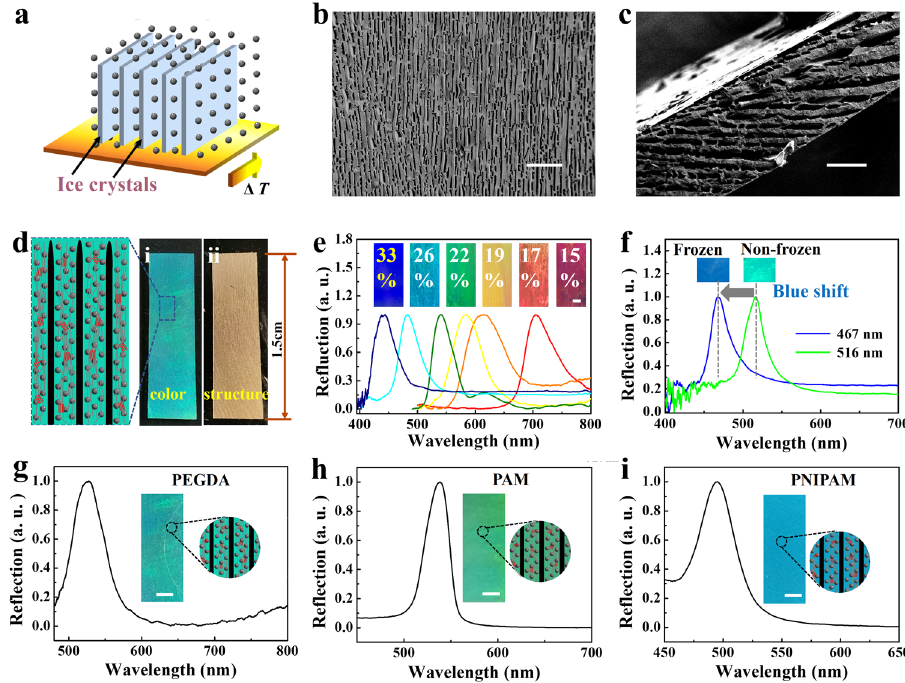
Fig. 3 Designable micrometer-sized structure, tunable structural color, and wide-applicable photopolymerizable hydrogel materials. a Schematic illustration of nanoparticles assembly process based on unidirectional ice-templating technology. b , c The SEM images of the surface ( b ) and cross section ( c ) of a directional II-TSCHF. d Optical images of the directional II-TSCHF; (i) the re fl ection image showed the color; (ii) the opaque transmission image displayed the directional stripe caused by the ice-template structure. e Optical images and corresponding re fl ection spectra of II-TSCHFs with various nanoparticles solution concentration. f Wavelength variations of the directional frozen II-TSCHF and the non-frozen fi lm. The subcooling is 7.9 K. The v/v ratio of H 2 O/PEGDA was 1:1. Nanoparticles with a diameter of 172 nm were employed. g – i Optical images and corresponding wavelength peak of the directional II-TSCHF fabricated by various hydrogel materials; g PEGDA; h PAM; i PNIPAM. Nanoparticles with a diameter of 172 nm were employed. The temperature was roughly − 7.9°C. The v/v ratio of H 2 O/PEGDA was 1:1. Scale bars are 200 μ m in ( b ), 100 μ m in ( c ), 2 mm in ( e ), and 1 mm in ( g, h, i